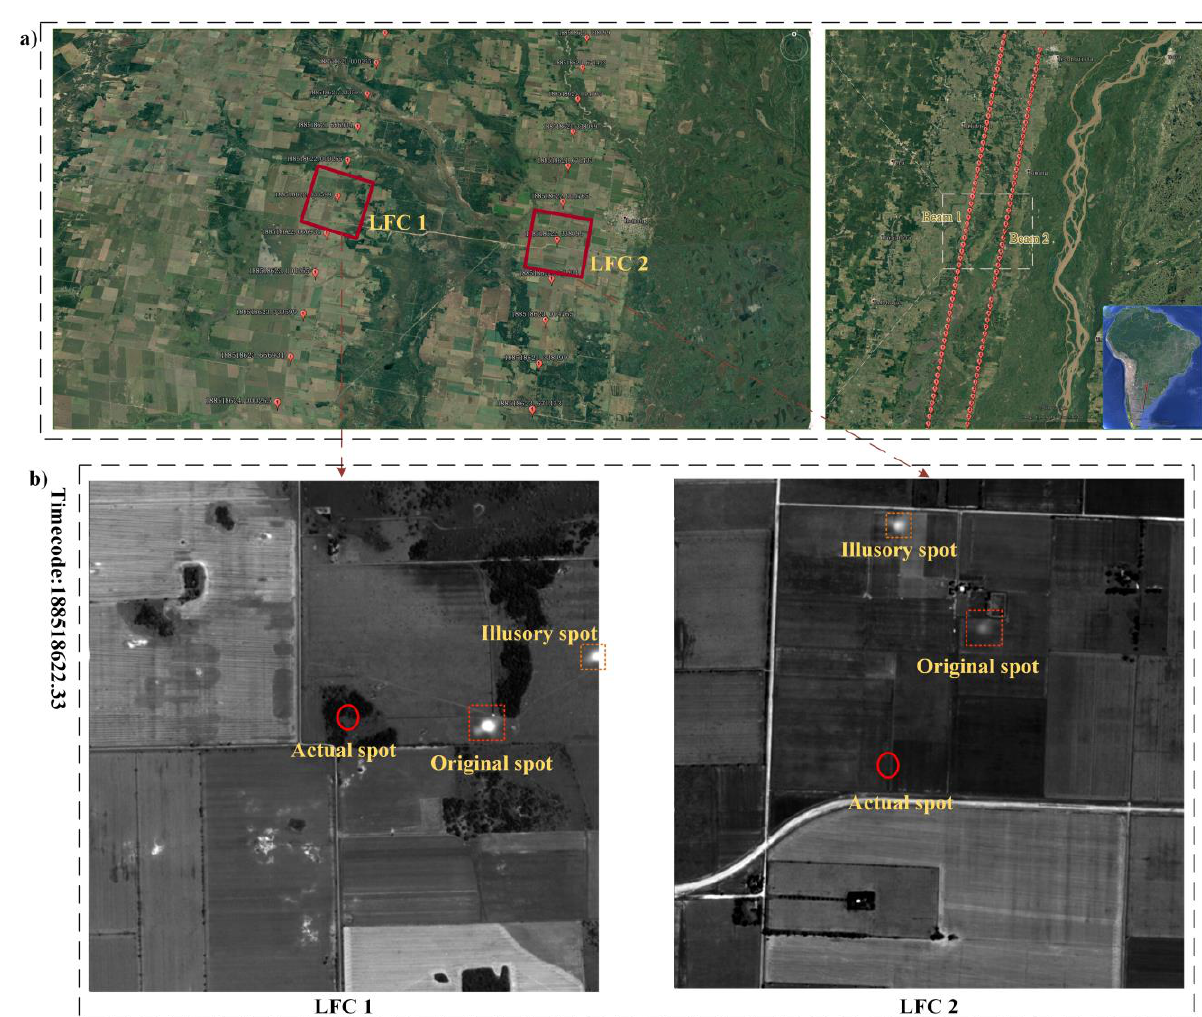
Figure 4. Laser data and LFI in the 755 th track (Imaging